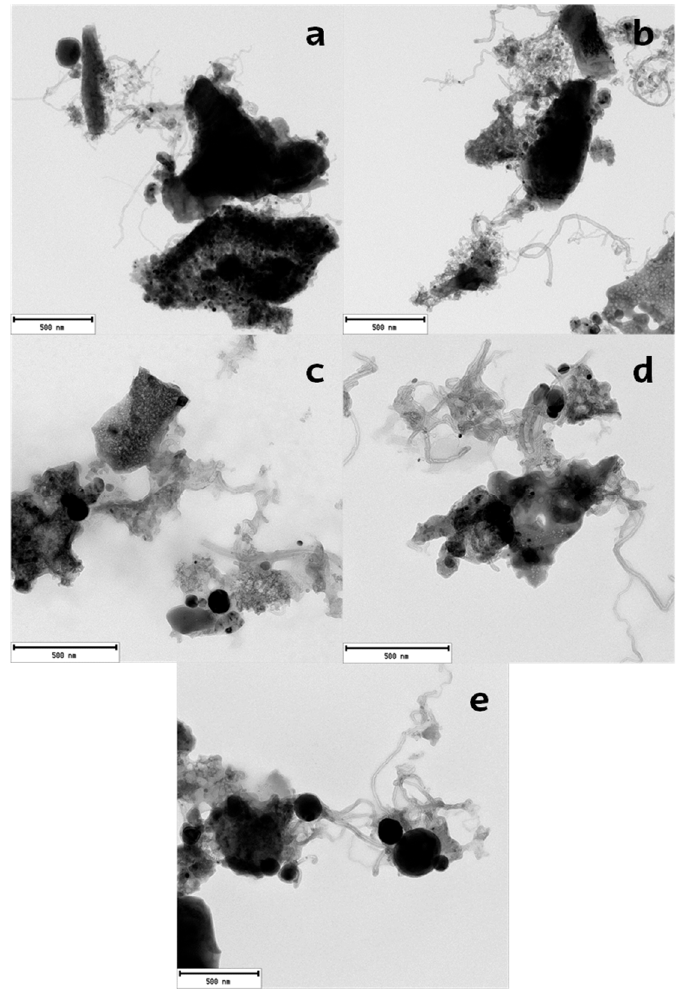
Figure 5. TEM images of the catalyst used in five consecutive reaction-regeneration cycles; ( a ) 1st cycle; ( b ) 2nd cycle; ( c ) 3rd cycle; ( d ) 4th cycle; ( e ) 5th cycle.